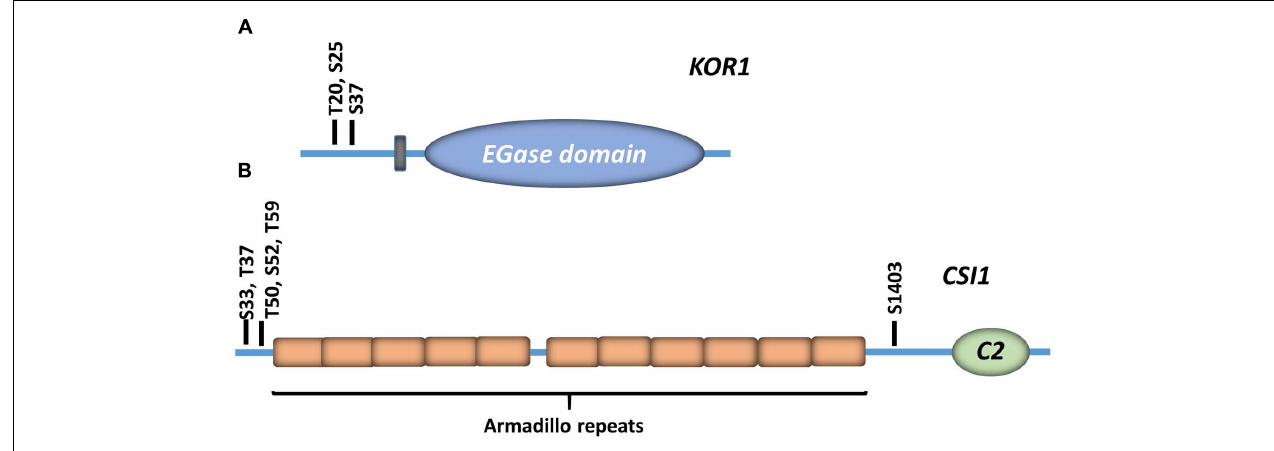
FIGURE 2 | Experimentally supported phosphorylation sites in accessory CSC subunits. The experimentally supported phosphorylation sites in the Arabidopsis KORRIGAN1 (KOR1) endo- β -(1 → 4)-glucanase (A) , and Cellulose Synthase Interactive protein 1 (CSI1; B) are indicated. Each residue and corresponding residue indices are indicated. The predicted transmembrane domain is indicated by a gray box, and the position of the endoglucanase domain (EGase) is also shown. CSI1 Armadillo repeats are shown in orange boxes, and the position of the C-terminal C2 domain (C2) is indicated.